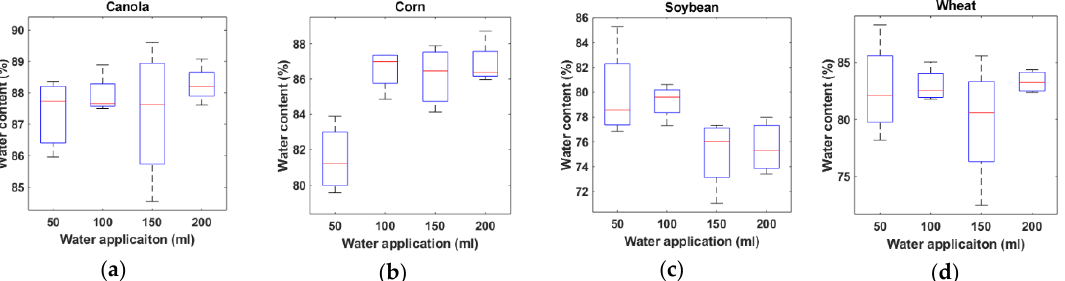
Figure 6. Boxplot of the leaf water content of ( a ) canola, ( b ) corn, ( c ) soybean, and ( d ) wheat. Here, the horizontal axis represents the rate of water application in mL, and the vertical axis represents the water content.